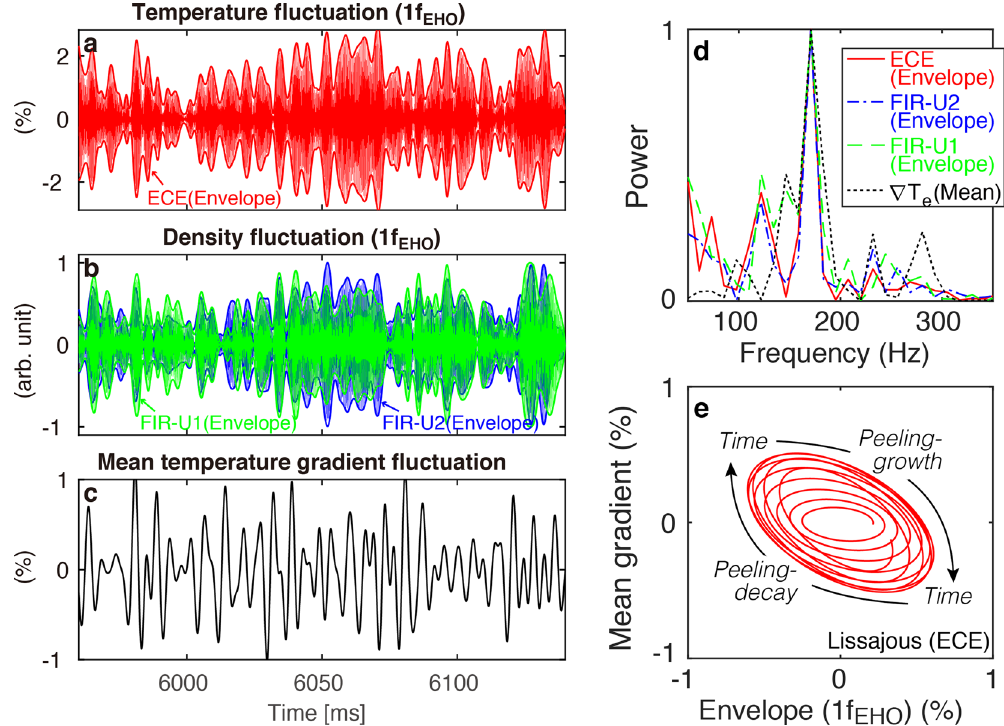
Fig. 6 Dynamical steady state of the peeling mode in the quiescent high-con fi nement (QH) mode (discharge E042870). Temporal behavior of the fl uctuations a of the temperature measured by the electron – cyclotron-emission (ECE), b of the density measured by the far-infrared (FIR) laser interferometers, FIR-U1 (green) and FIR-U2 (blue), and c of the mean temperature gradient (discharge E042870). A bandpass fi lter ( f BPF = 9.53 – 9.65 kHz) around the fundamental component of edge-harmonic oscillations (1f EHO ) was applied to the raw data in ( a ) and ( b ), while a bandpass fi lter with f BPF = 0.1 – 0.3 kHz was applied in ( c ). Frequency spectra ( d ) for the envelope of the data (ECE: solid red line, FIR-U2: blue dash-dot line, and FIR-U1: green dashed line) shown in ( a ) – ( b ), and for the mean temperature gradient data (black dotted line) shown in ( c ). e The relationship between fl uctuations of the mean temperature gradient (Fig. 6c) and the envelope signal of the 1f EHO mode (Fig. 6a) from the ECE data after applying an additional bandpass fi lter around f envelope = 170 ± 15 Hz traces a Lissajous fi gure. The time-window for ( d ) – ( e ) is t = 6.01 – 6.07 s. The clockwise arrows of the peeling-growth (-decay) in ( e ) denote the temporal evolution of the increment (decrease) of the envelope of the 1f EHO mode as the mean gradient becomes small